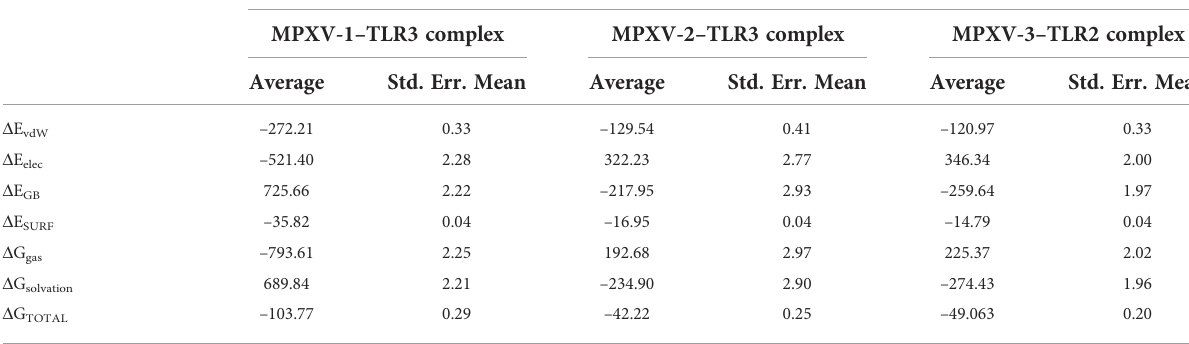
TABLE 7 MM/GBSA free energy calculations and individual free energy components of vaccine-TLR complex. Energy